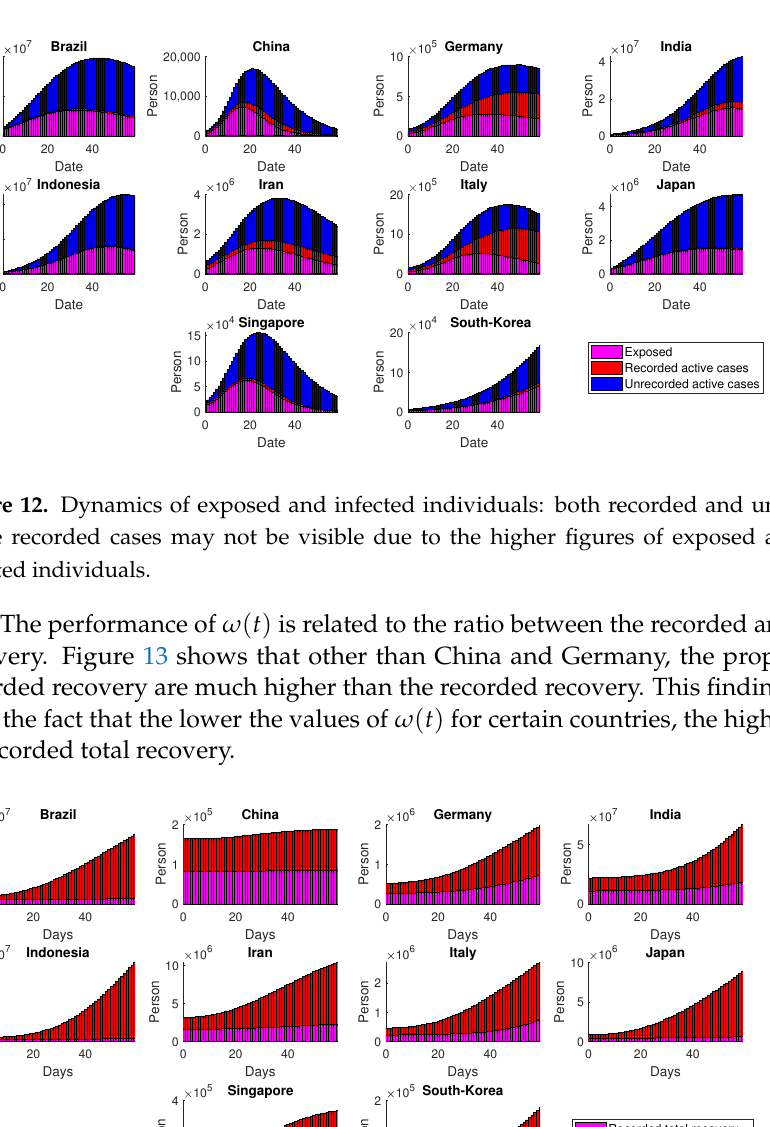
Figure 13. Estimated dynamics of total recovery resulted from both recorded and unrecorded